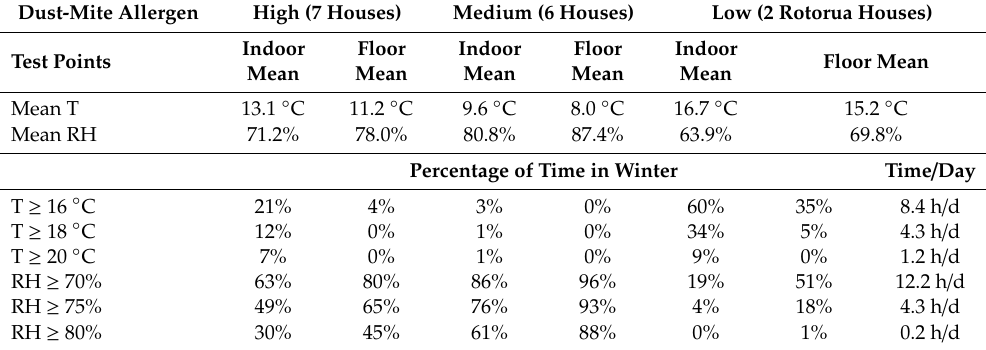
Table 4. Winter indoor mean microclimatic conditions of the sample houses with di ff erent levels of dust-mite